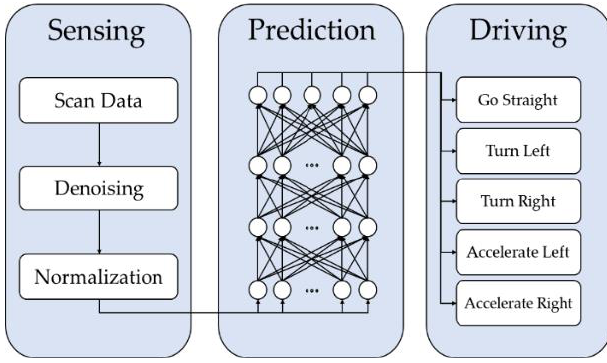
Figure 2. Indoor Autonomous Driving System with LiDAR.